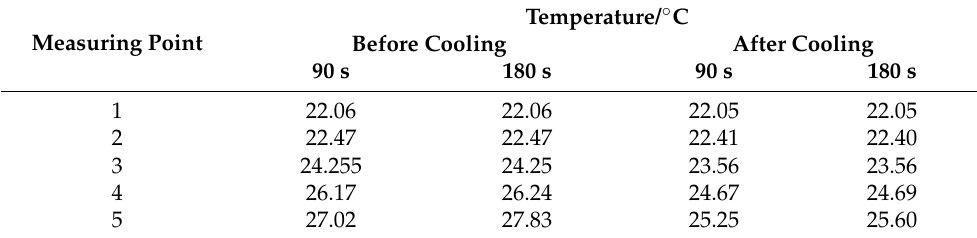
Figure 8. Temperature variation of measuring points before and after cooling. Table 2. Temperature of measuring points.